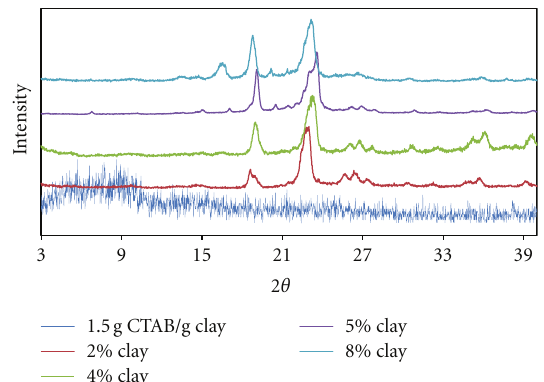
Figure 4: XRD patterns for produced PEO/clay nanocomposites at various clay compositions (0.7g CTAB/g clay ratio).